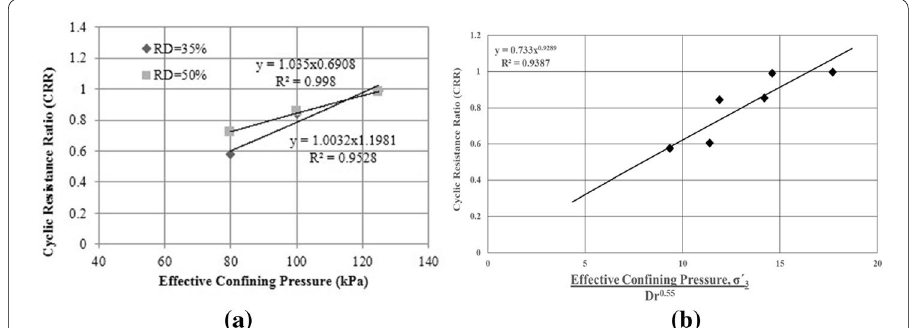
Fig. 14 a Variation of cyclic resistance ratio of Kanpur soil with effective confining pressure at various relative densities. b Variation of cyclic resistance ratio of Kanpur soil with effective confining pressure normalised to relative